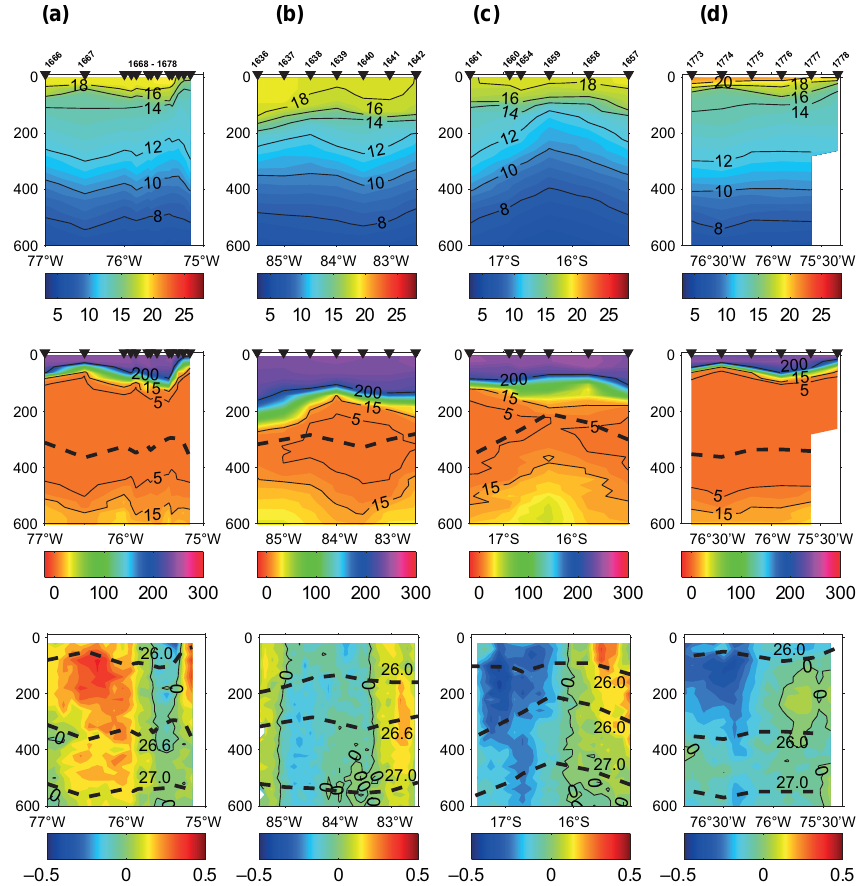
Figure 2. Hydrographic conditions at the time of sampling in the ETSP (0-600m depth). Temperature in ◦ C (upper panels), O 2 in µmolkg − 1 (middle panels), and zonal (a, c, d) as well as meridional. (b) velocity in ms − 1 (lower panels) for eddies A, B, and C during the M90 cruise (November 2012; a–c ), as well as for eddy A during the M91 cruise (December 2012; d ) are shown. Locations of CTD profiles are marked by black triangles (cf. Fig. 1), and the isopycnal σ θ = 26.6kgm − 3 near the core of the OMZ is included in the O 2 sections as a black dashed line. Dashed lines in the velocity plots indicate potential